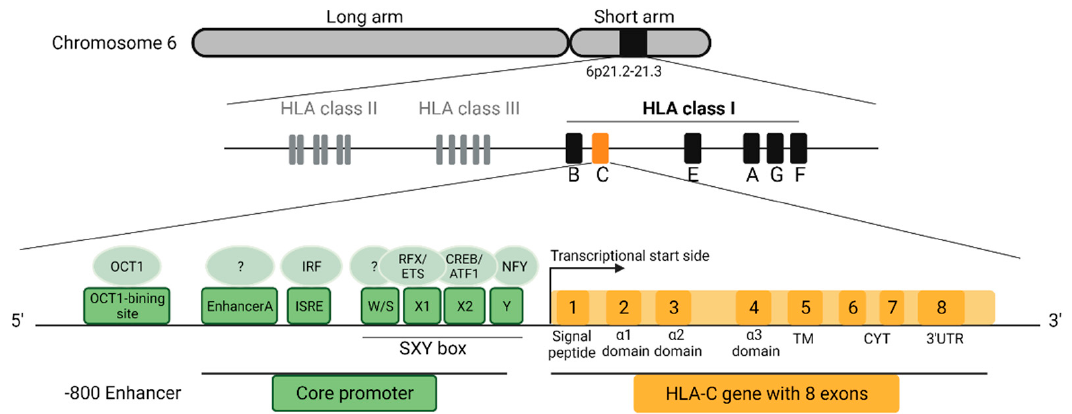
Figure 1. Location and structure of the HLA-C gene. HLA class I genes are located on the short arm of chromosome 6. The transcription of HLA-C is regulated by core promoter elements but also by distal regulators. The core promoter consists of the EnhancerA, ISRE and a SXY box. Compared to HLA-A and -B , the EnhancerA of HLA-C has no functional binding site for NF κ B. ISRE activation is mediated through IFN γ stimulation which recruits the transcription factor IRF. The SXY box is composed of the W/S, X1, X2 and Y and is important for the binding of NLRC5 and formation of the enhanceosome. Transcription factors for W/S are still unknown, but X1 has binding sites for RFX and ETS, X2 has binding sites for CREB and ATF1 and Y for NFY. Moreover, the non-coding region of HLA-C contains an OCT1 binding site ~800 bp upstream of the core promoter region. HLA-C has 8 exons. Exon 1 encodes the signal peptide. Exon 2 and 3 encode the α 1 and α 2 domains which build the peptide binding grove. The α 3 domain (exon 4) is connected to the transmembrane domain (TM) and cytoplasmic tail (CYT) (exon 5–7), anchoring the molecule to the cell membrane. Created with BioRender.com.